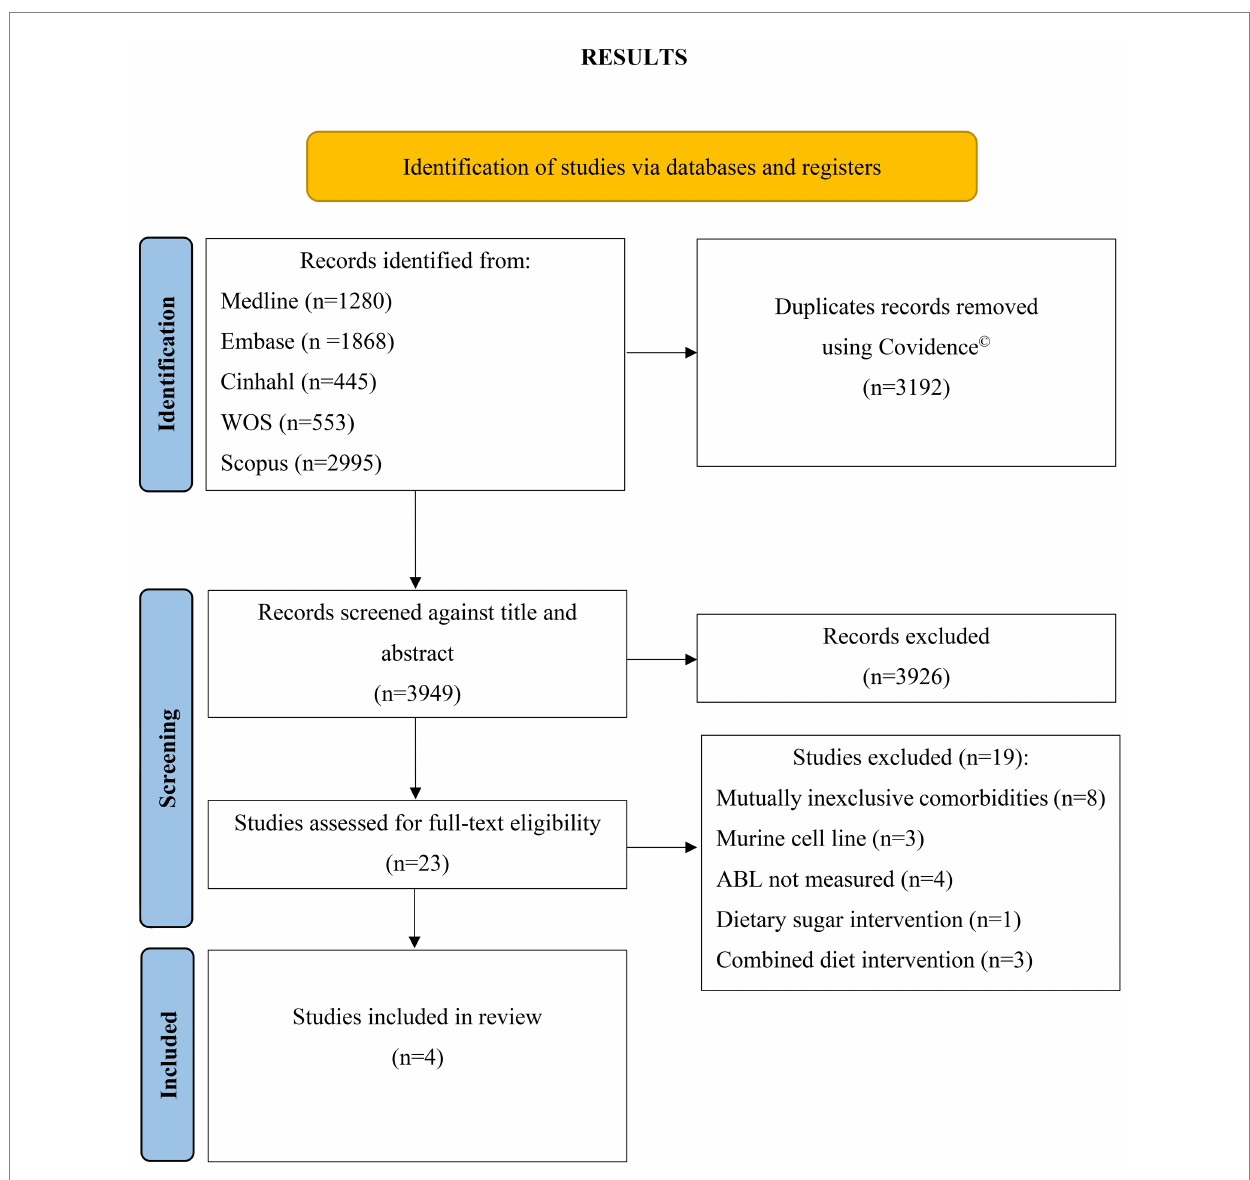
FIGURE 1 PRISMA 2020 flow diagram for new systematic reviews which included searches of databases and registers only. WOS, Web of Science; ABL, alveolar bone